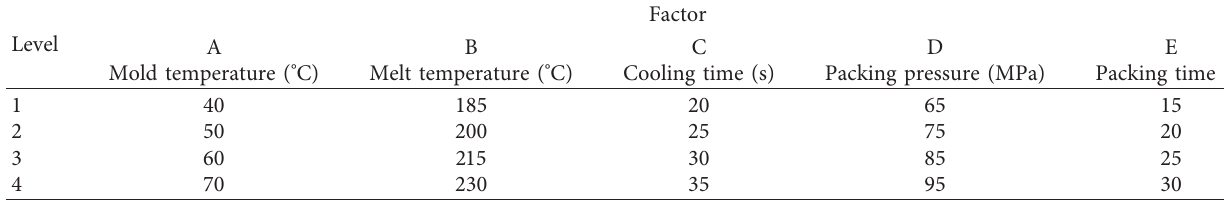
Table 5: Level factor settings.